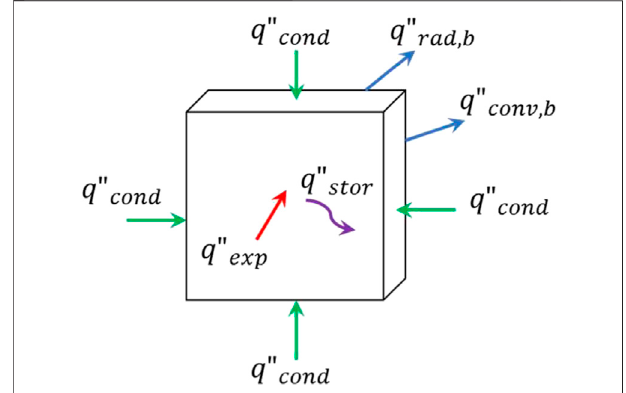
FIGURE 2 | Schematic of the energy balance on the stainless steel plate used in the inverse heat transfer